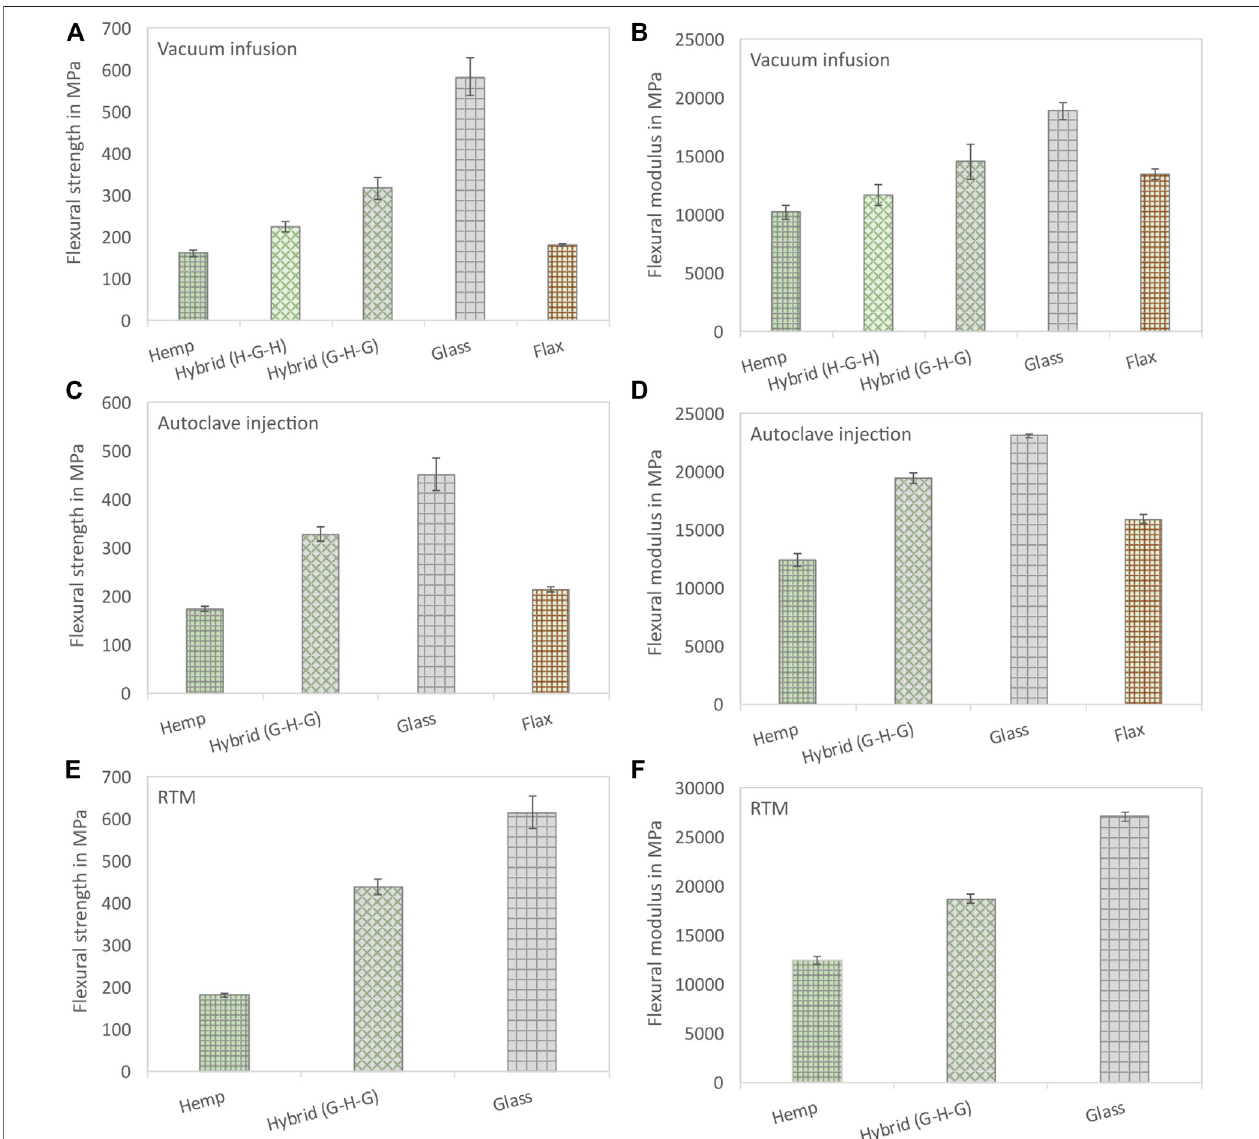
FIGURE 10 | Flexural strength and fl exural modulus (mean value ± standard deviation) of composite laminates produced by vacuum infusion (A,B) , autoclave injection (C,D) and RTM (E,F) .